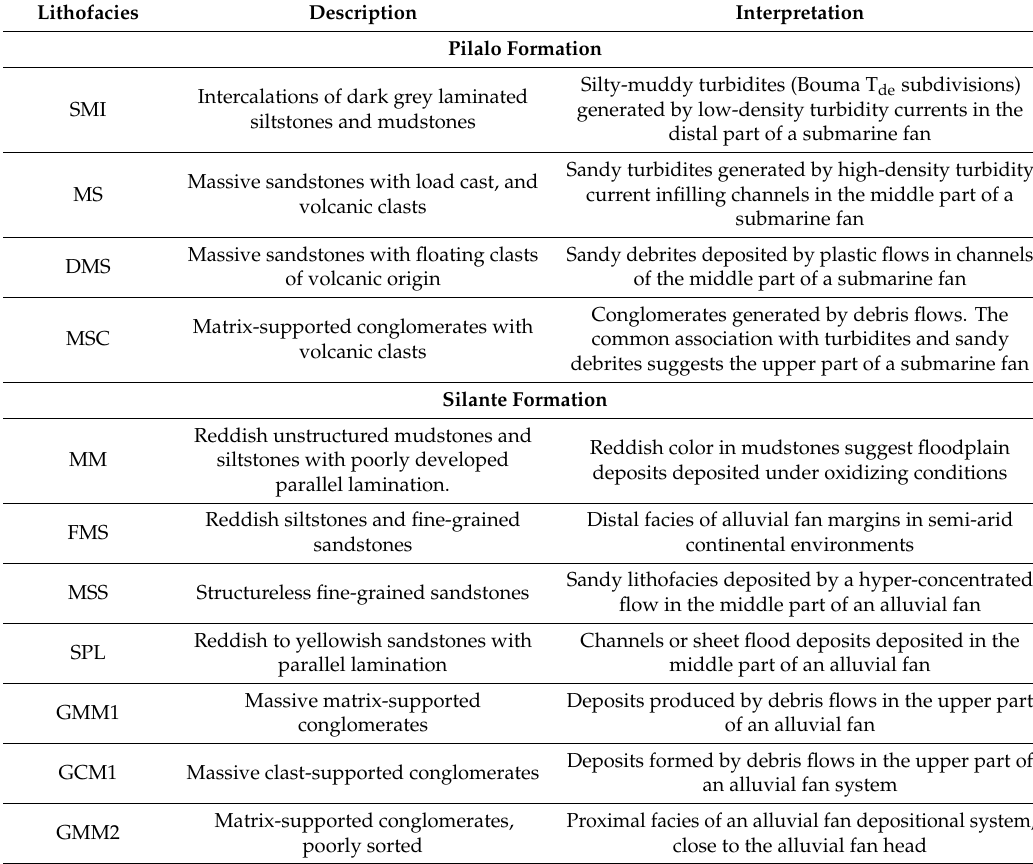
Table 2. Lithofacies of the Pilalo and Silante